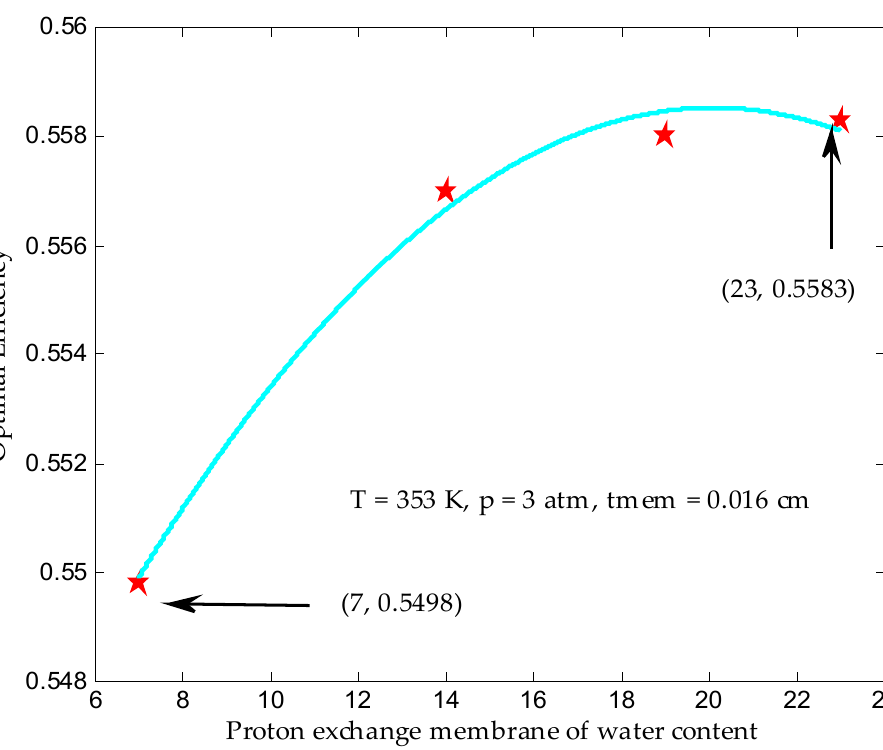
Figure 9. Optimal output efficiency varying with membrane thickness.